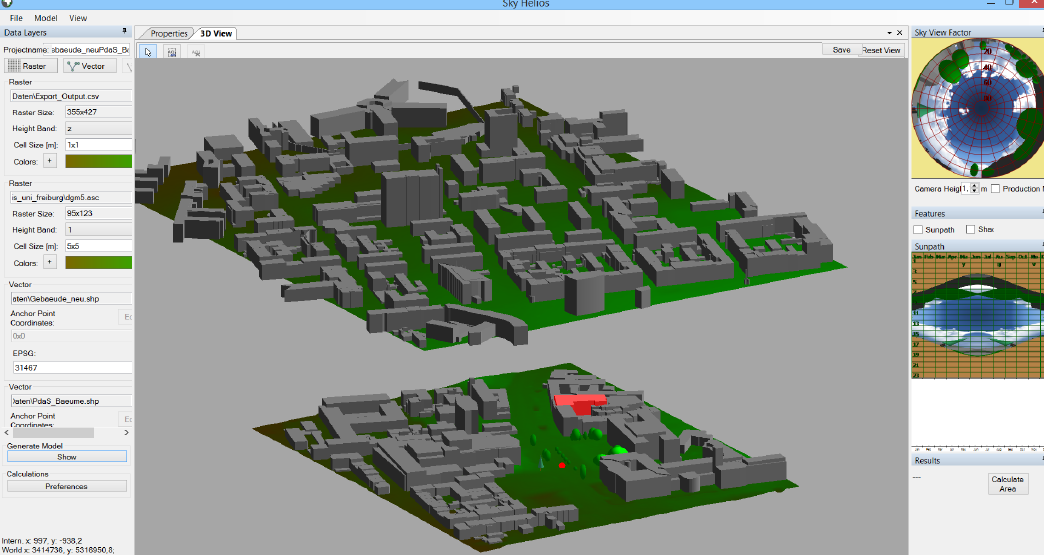
Figure 2. Screenshot of SkyHelios main window showing a combined model domain consisting of two areas of interest in Freiburg, Southwest Germany: the “Institutes Quarter” and the “Place of the Old